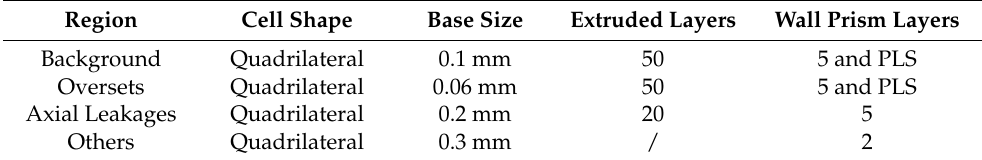
Table 2. Mesh characteristics. PLS: prism layer